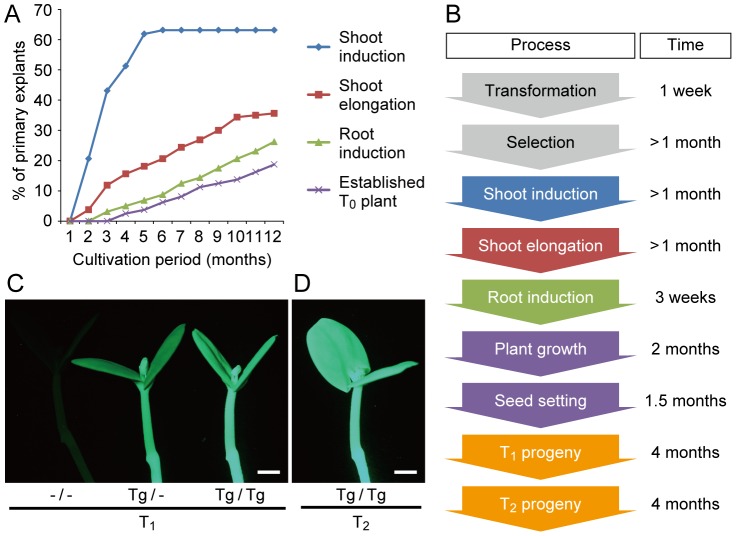
Establishment of transgenic plants.A. Time course of establishment of transgenic T0 plants from cotyledonary node explants (n = 160). Each line indicates the frequency of Agrobacterium-infected explants that reached the process indicated in (B). B. Schematic representation of the entire transformation procedure. C. Green fluorescent images of T1 seedlings of a single T-DNA insertion line (#1 in Figure 6). The zygosity of T1 progeny [non-transformant (−/−), hemizygote (Tg/−) or homozygote (Tg/Tg)] produced by self-crossing of a T0 plant could be determined based on fluorescence intensity of the plantlet. D. Green fluorescent image of homozygous T2 seedling produced by self-crossing of a homozygous T1 plant. Scale bar, 2 mm.